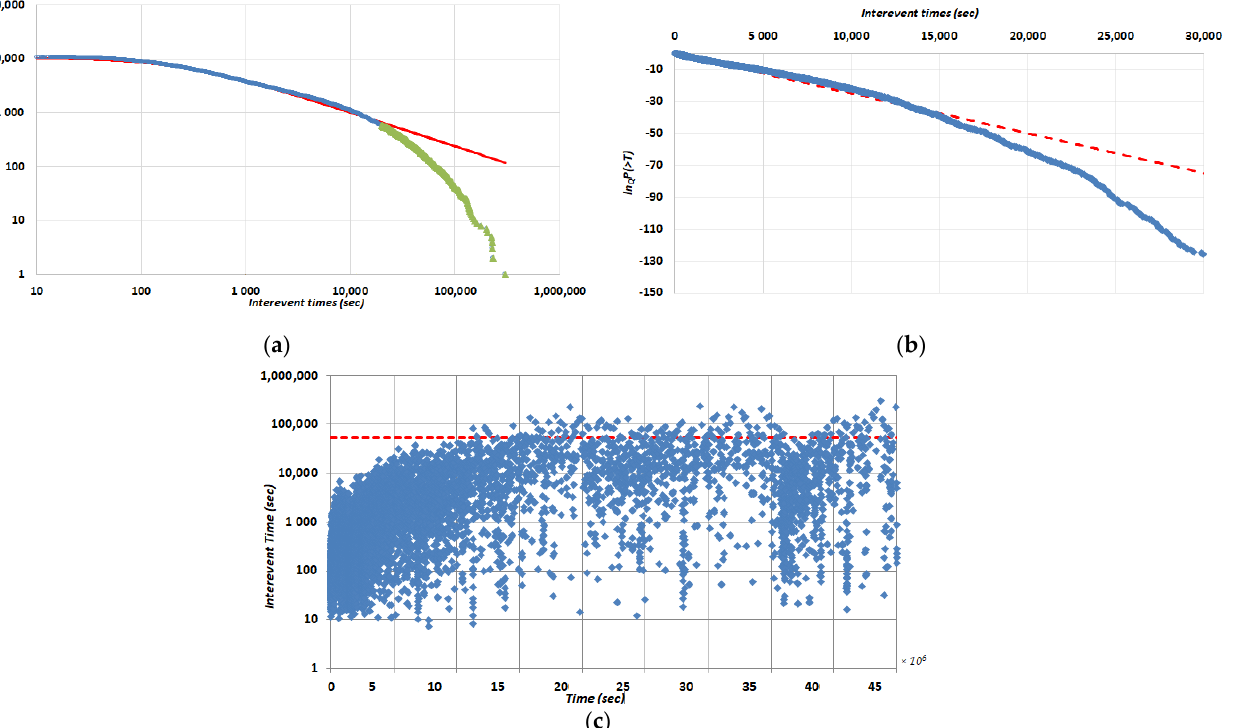
Figure 8. ( a ) The interevent times CDF of the 2017 M w 6.5 Kos Earthquake, for the aftershocks with M > M c . The scarlet line is the Q -exponential fitting with q = 1.63. The change of colors indicates the crossover between the NESP (blue circles) and BG statistics (green triangles). ( b ) The ln Q P (> T ) as a function of T , where the red line is the fitting with q = 1.63 and correlation coefficient 0.9935 up to T c . T c value close to 15,005 s is suggested by the deviation from linearity. ( c ) Interevent time T evo- lution with time t since the main shock. The scarlet line illustrates the T c value.